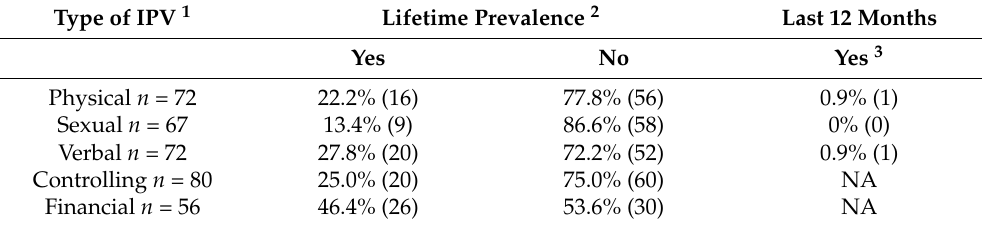
Table 1. Prevalence of ever-partnered women experiencing intimate partner violence